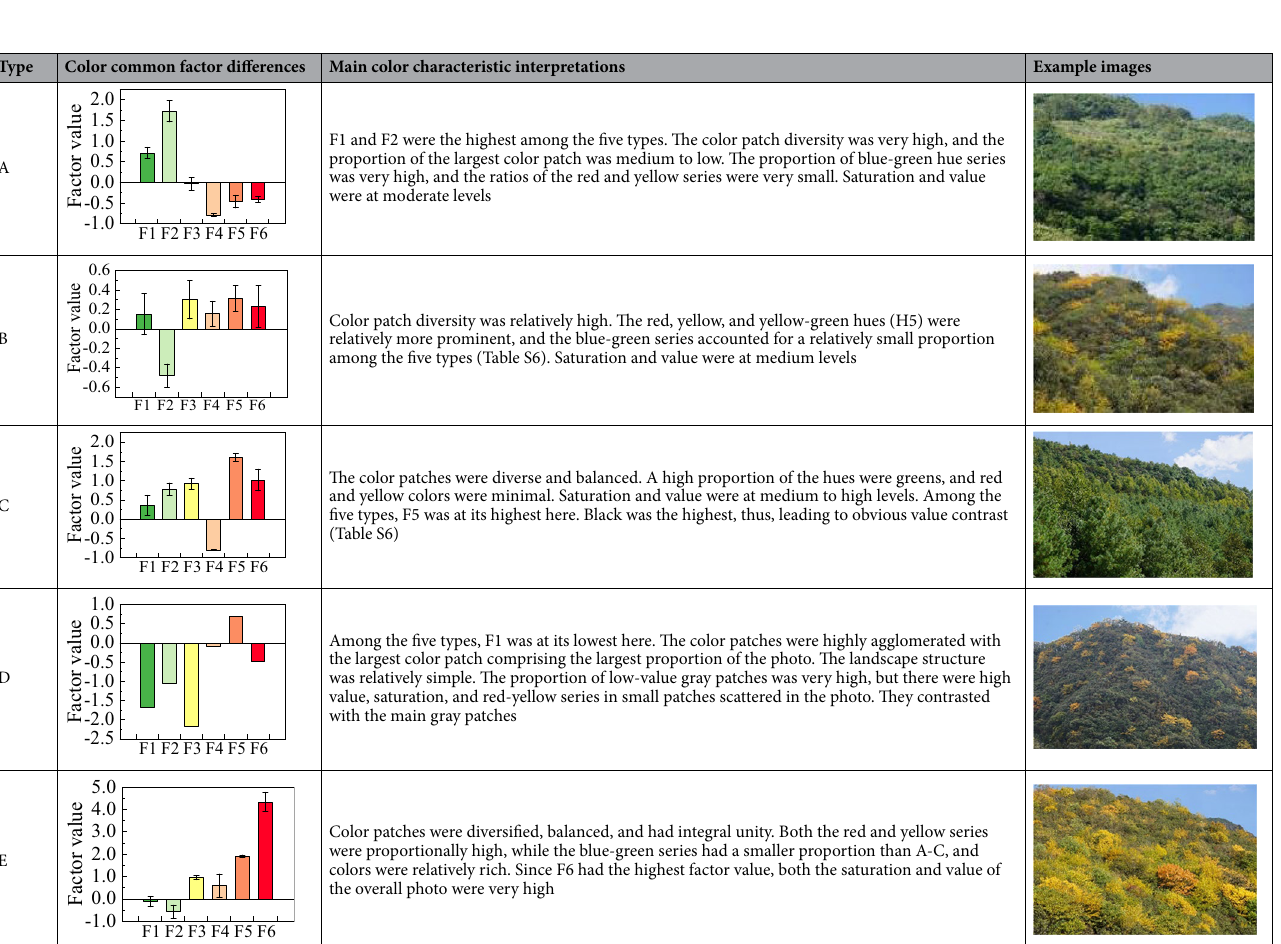
Color patches were diversified, balanced, and had integral unity. Both the red and yellow series were proportionally high, while the blue-green series had a smaller proportion than A-C, and colors were relatively rich. Since F6 had the highest factor value, both the saturation and value of the overall photo were very